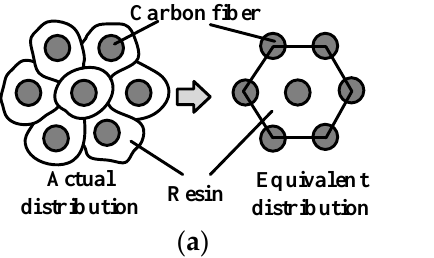
Figure 1. The schematic of fiber cutting angle.